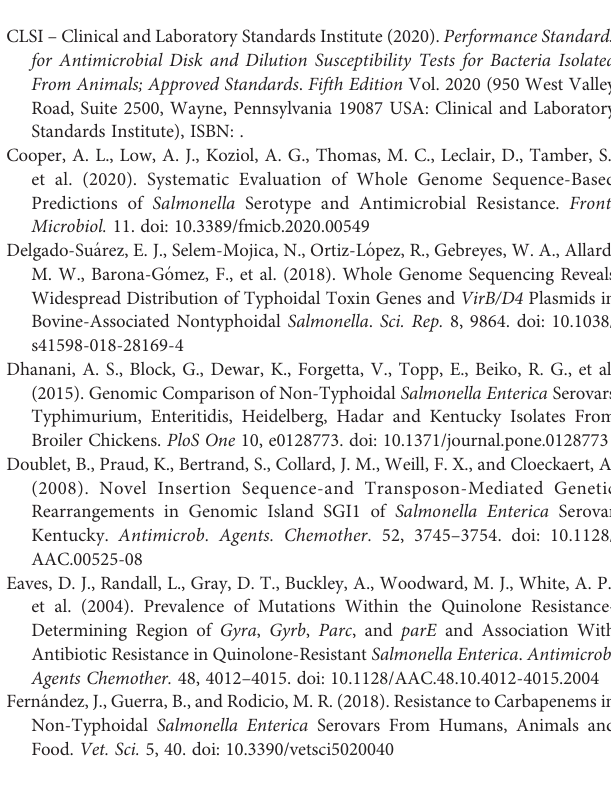
Supplementary Table 1 | Detailed information on all 248 Salmonella Kentucky from livestock in Africa, Asia, and